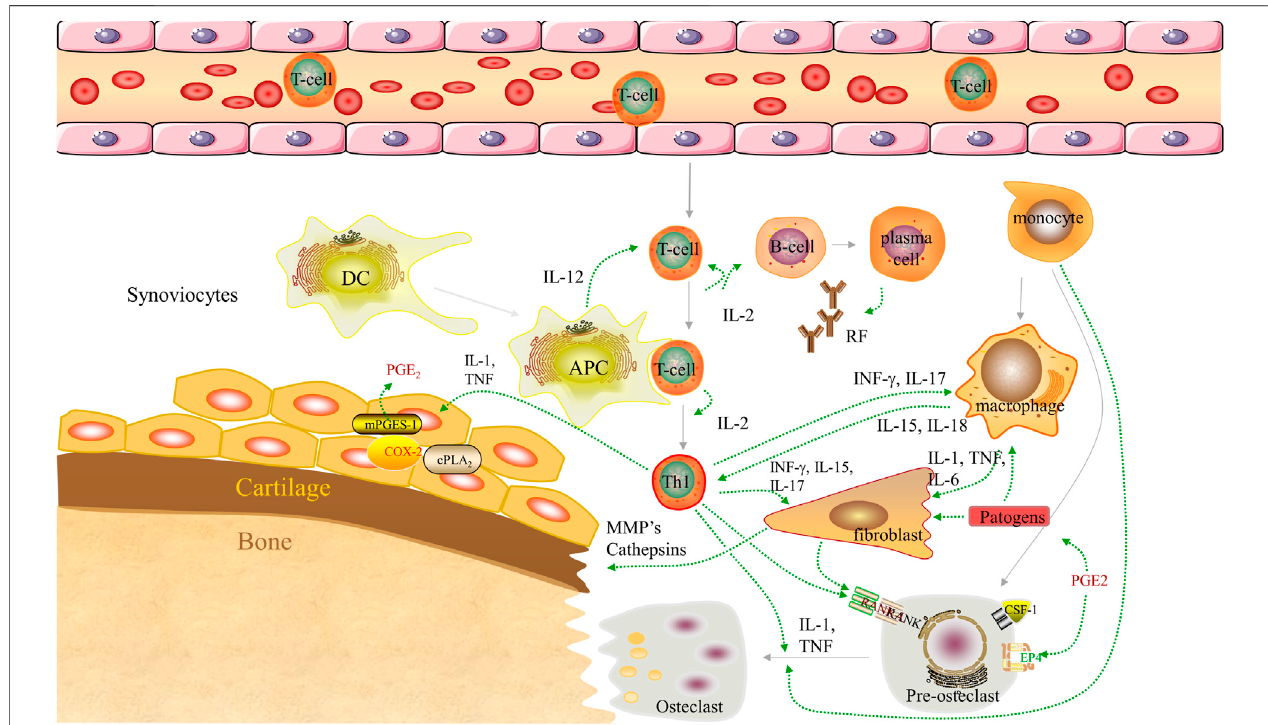
FIGURE 1 | Pathogenesis of RA. Dendritic cells complexed with autoantigen to activate naive T cells. Differentiated T cells stimulate B cells to produce autoantibodies [rheumatoid factor (RF)]. B cells present autoantigens to T cells, leading to their activation. Synovial macrophages are activated by T cells to release pro- in fl ammatorycytokines(TNF- α ,IL-1,andIL-6),drivingtheactivationofsynovial fi broblastsandinducingosteoclastproduction.Inaddition,themonocytesubpopulations of the arthritic synovium can differentiate into macrophages and osteoclasts. Collectively, these components play an important role in the destruction of bones, cartilage, and the synovium. APC, antigen-presenting cell; COX-2, cyclooxygenase-2; cPLA2, cyosolic phospholipase A2; CSF-1, colony-stimulating factor-1; DC, dendritic cell; EP4, prostaglandin Ereceptor subtype 4; IFN- ɣ , interferon-gamma; IL-, interleukin; MMP, matrix metalloproteinase;mPGES-1, microsomal prostaglandin E synthase-1; PGE2, prostaglandin E2; PGF2, prostaglandin F2; RA, rheumatoid arthritis; RANK, receptor activator of nuclear factor-kB; Th1, T helper 1; TNF- α , tumor necrosis factor α